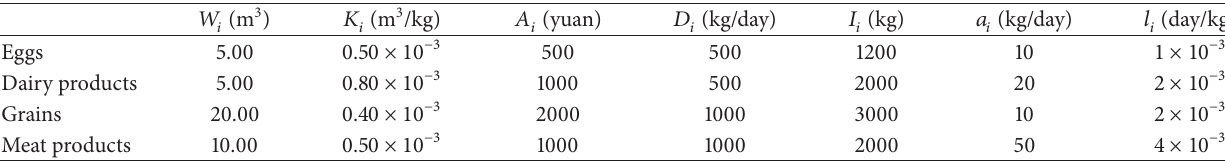
Table 1: Determined parameters.